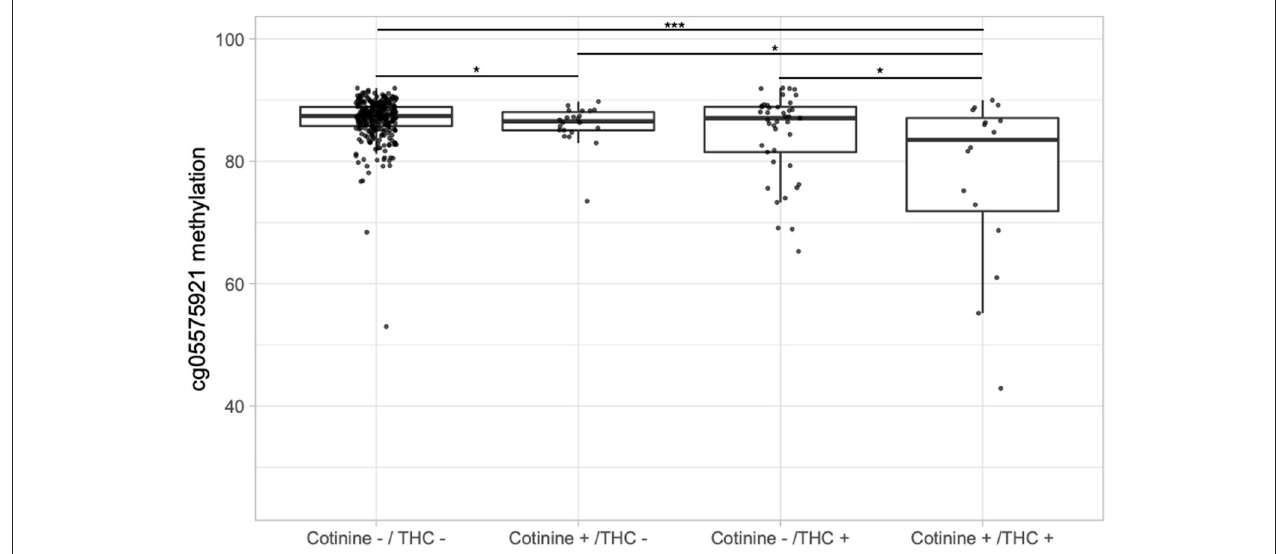
FIGURE 2 | Boxplots of DNA methylation at cg05575921 vs. serum cotinine and/or THC positivity in the 12th grade. “Cotinine + ” indicates > 3ng/mL and “THC + ” indicates > 0.5ng/mL. Significance codes: * p ≤ 0.05; ** p ≤ 0.01; *** p ≤ 0.001 (Tukey’s Honest Significant